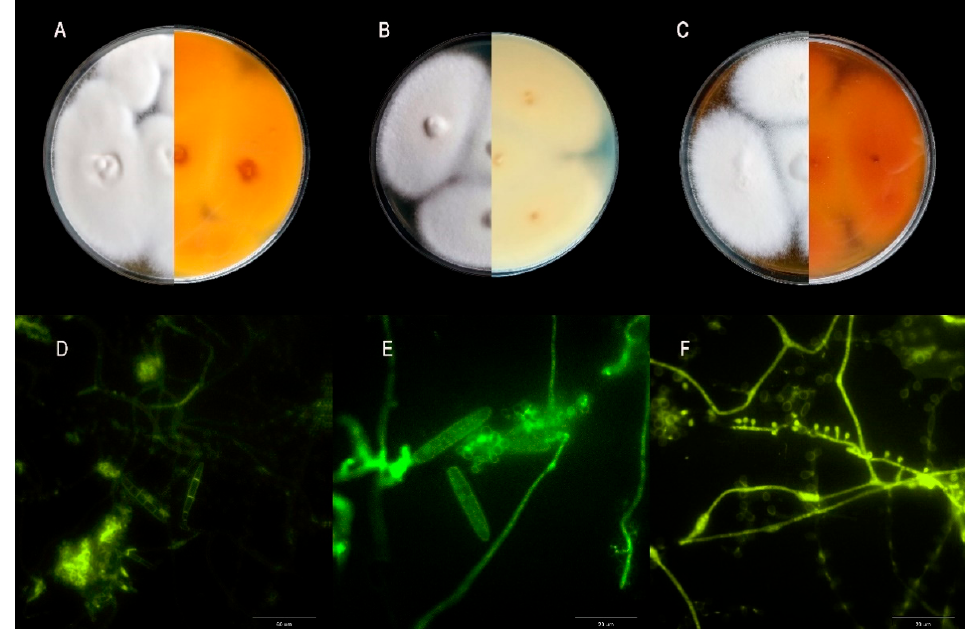
Figure 1. The micro- and macroscopic morphology of Trichophyton mentagrophytes after 21 days of incubation. ( A ) Sabouraud dextrose agar (SDA). ( B ) Potato dextrose agar (PDA). ( C ) Malt extract agar (MEA). ( D – F ) micromorphology after calcofluor white staining (Olympus BX51, Tokyo, Japan). ( D ) At 400 × magnification. ( E , F ) At 1000 × magnification. Notes: The selection of the three